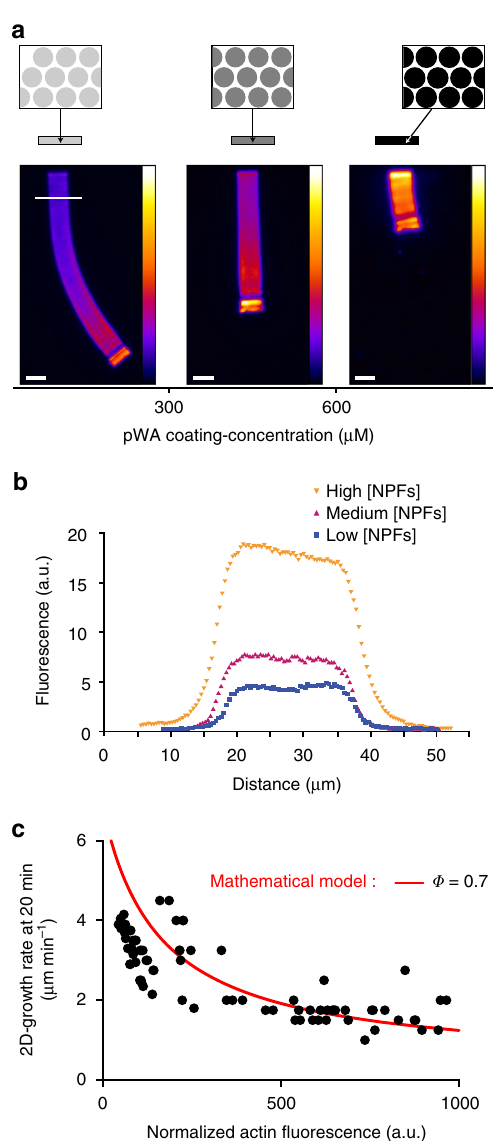
Fig. 4 Actin fi lament density controls the growth rate of branched actin network. a Images of typical LMs of variable fi lament density reconstituted on bar- shaped patterns of constant geometry and variable NPF concentration. The images taken after 78 min of actin assembly reveal that denser networks grew slower than the sparser ones. b The network density was measured across the LMs (along the white line as indicated in a , left image ). c Network growth rates at 20 min were represented as a function of the network fl uorescence. Simulated growth rates at 20 min ( red solid line ) were calculated as a function of computed fi lament densities and according to the measured parameter Φ = 0.7 (Fig. 1; Supplementary Methods). Scale bars are 15 µ m (see also related Supplementary Fig.